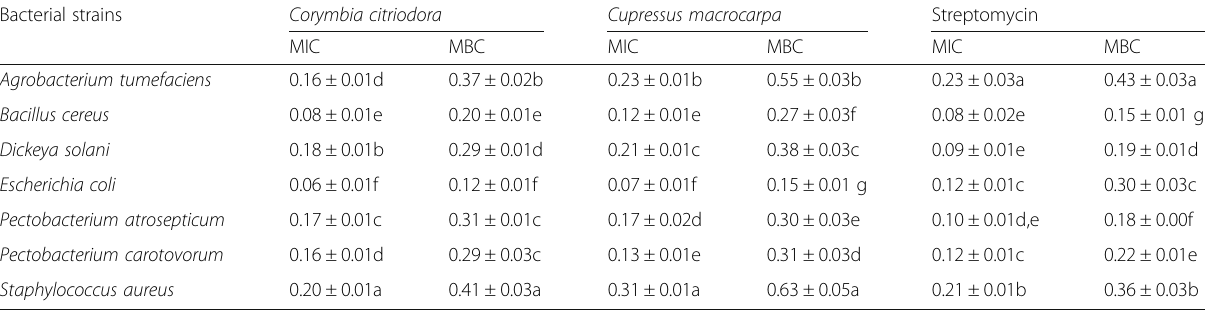
Table 2 Minimum inhibitory (MIC) and bactericidal concentration (MBC) of the essential oil (mg/mL) of Corymbia citriodora